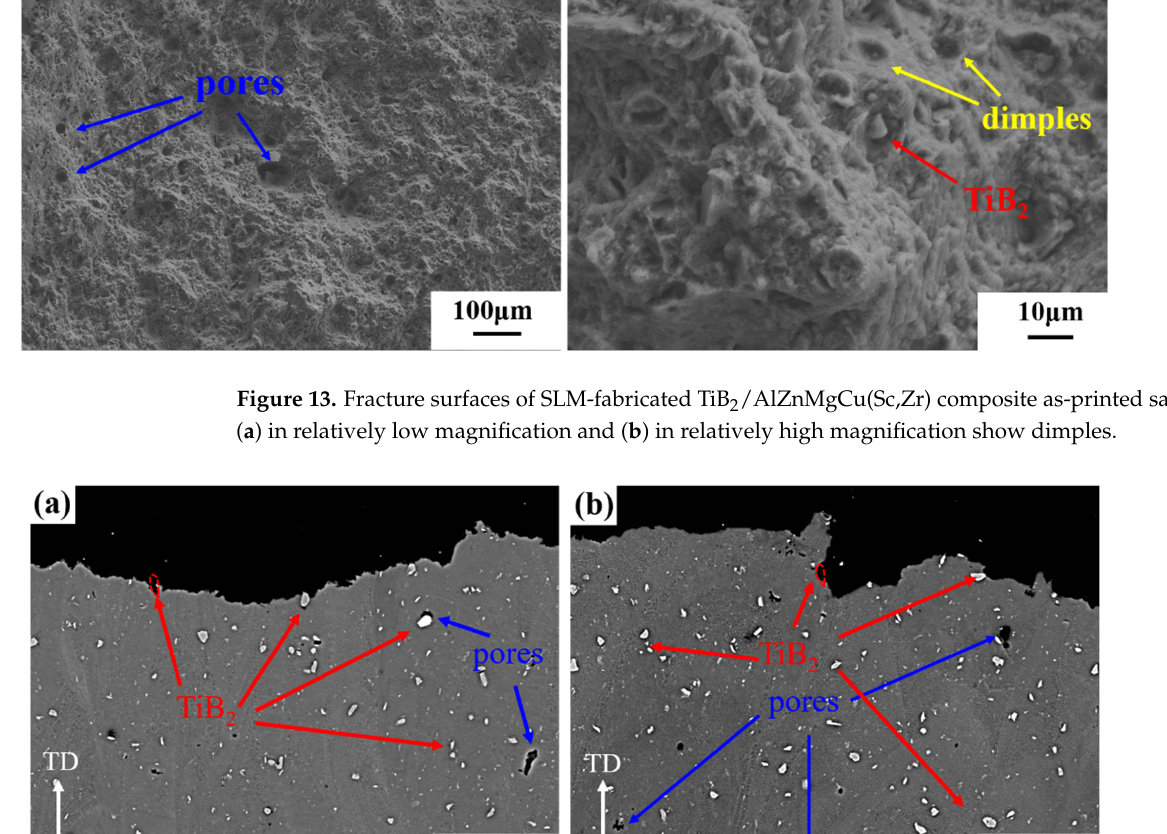
Figure 13. Fracture surfaces of SLM-fabricated TiB 2 /AlZnMgCu(Sc,Zr) composite as-printed sample ( a ) in relatively low magnification and ( b ) in relatively high magnification show dimples.